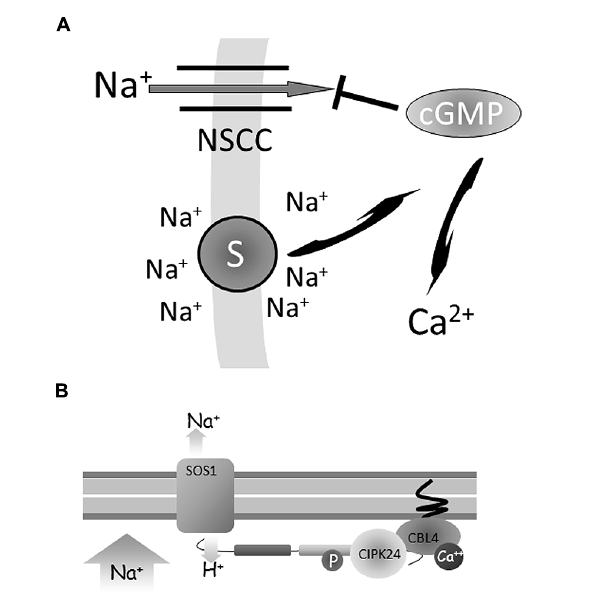
FIGURE 5 | Regulation of Na + flux. (A) A change in intra- or extracellular Na + may be reported by a (membrane–based) Na + sensor.This signal is translated into increased levels of cyclic GMP (cGMP) which in turn inhibits non-selective ion channel (NSCC) activity and thus reduces Na + influx. cGMP also affects transcription of many genes and also may be relayed downstream by calcium. (B) When salt is absent, the Na:H antiporter SOS1 is inactive. In the presence of salt a putative Ca 2 + signal activates the calcineurin B like protein (CBL4) to interact with the CBL interacting